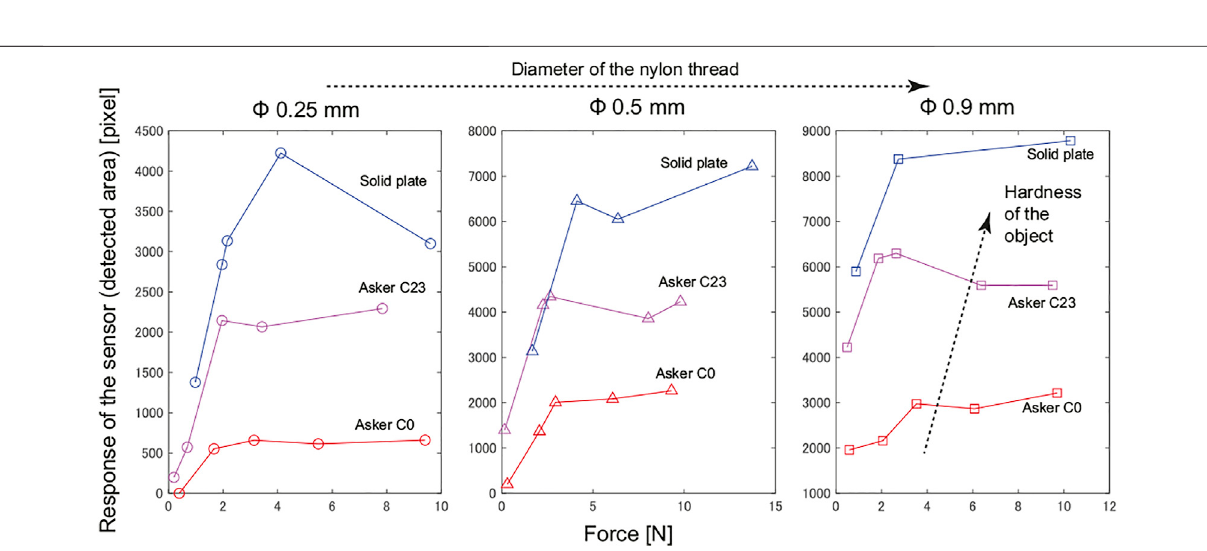
Frontiers in Robotics and AI |